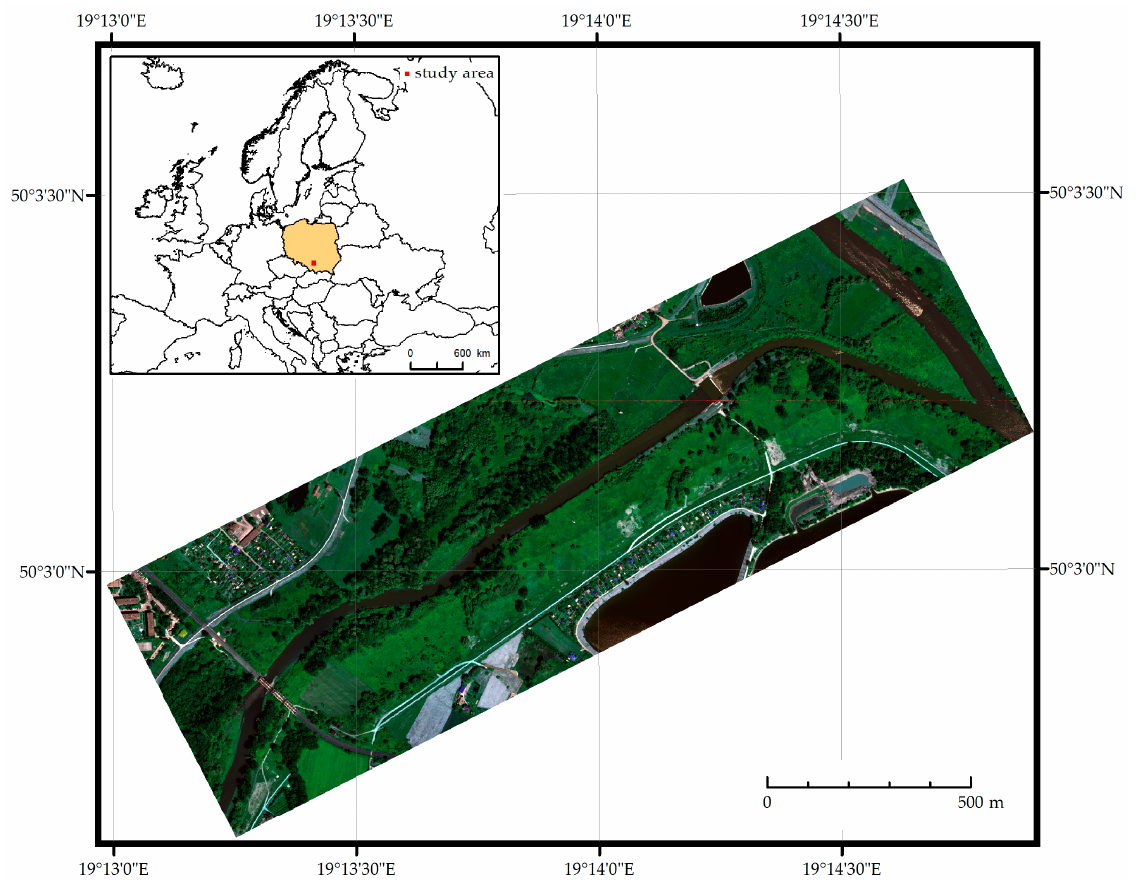
Figure 2. Study area—HySpex image (RGB mosaic) from 22 June 2016 and its location in Europe. Table 1. The characteristics of Rubus caesius and non- Rubus vegetation in each campaign.